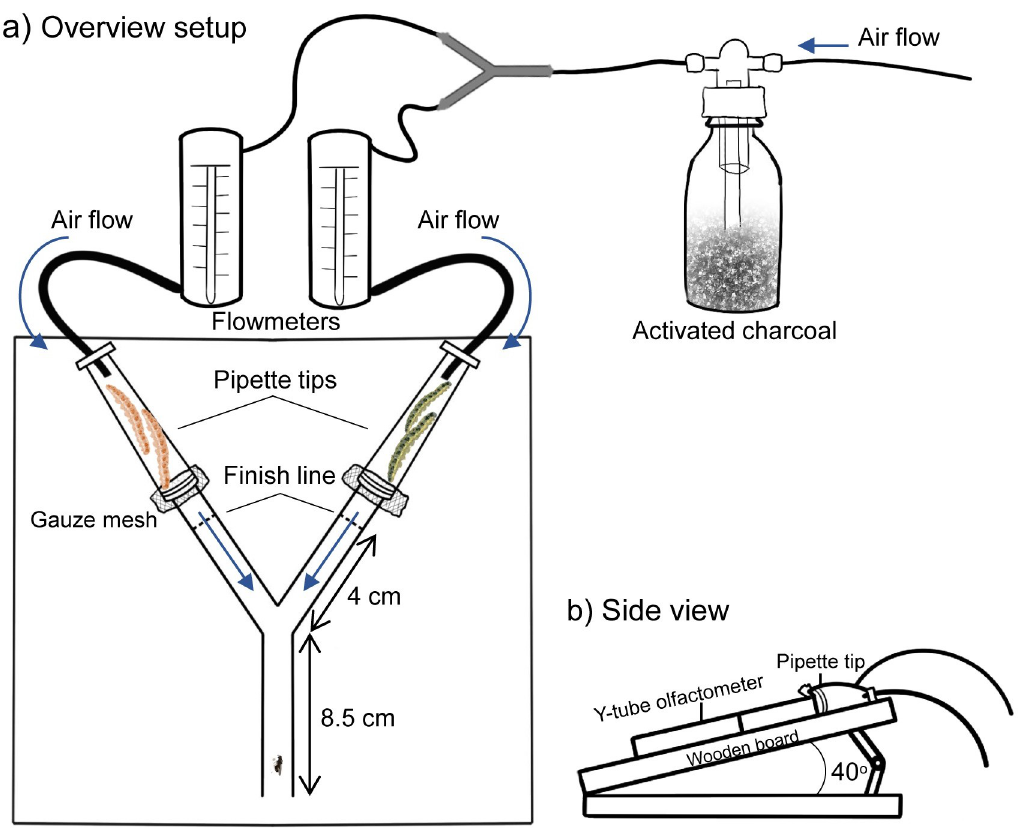
Fig 8. Y-tube olfactometer setup. a) The setup consisted of a Y-tube with an 8.5 cm-long stem, two 5-cm-long arms (angle between both arms of 65˚) and a diameter of 0.9 cm. A fine gauze mesh was placed over each end of the Y-tube to create a physical barrier, then a 5 mL transparent pipette tip containing caterpillars was mounted on each end of the Y-tube. A charcoal filtered airflow of 500 mL min -1 was split, continuously measured with flowmeters and led through both arms, sealed with Teflon tape. Hyperparasitoid females were released at the basis of the Y-tube and tests concluded once they passed the finish line for at least 15 seconds. b) The setup was mounted on a wooden board and tilted upward with an angle of 40˚ towards a single light